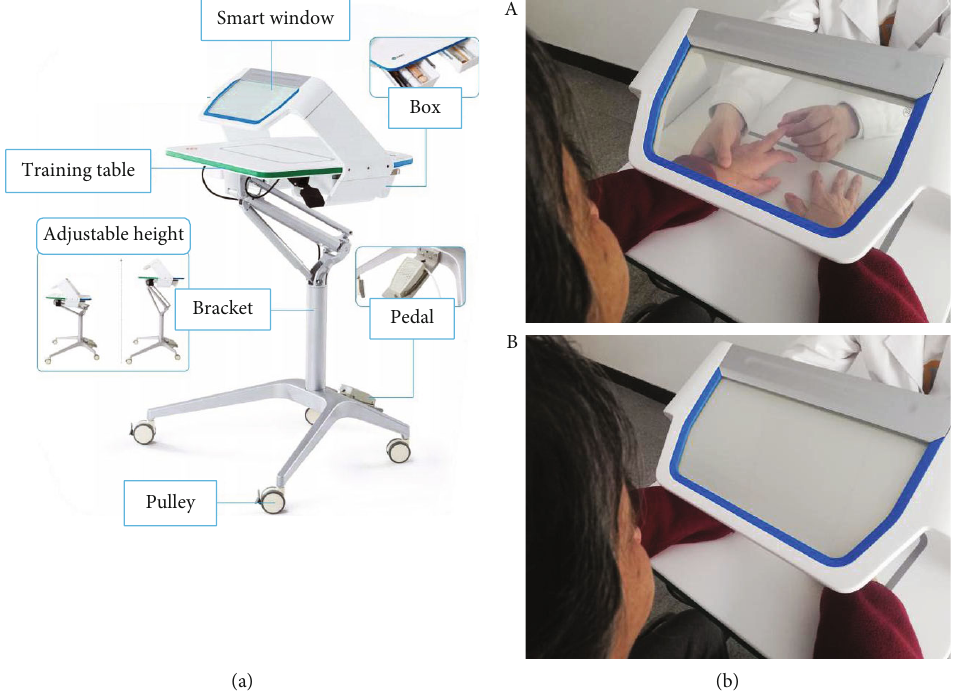
Figure 1: The visual-based sensory training setup. (a) The appearance and composition of the setup. (b) The smart window is in the transparent mode (A) and the opaque mode